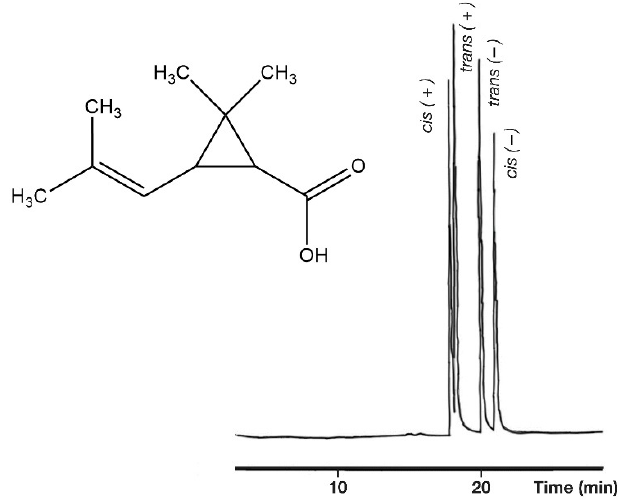
Figure 7. Chiral and cis ‐ trans separations of chrysanthemic acid isomers as free acids. The peaks of trans isomers elute between the peaks of cis isomers. Conditions: instrument, Shimadzu GC/MS ‐ QP5000 GC/MS; column, 25 m × 0.22 mm; stationary phase, Cydex ‐ B (0.25 μ m); carrier, He (50 cm/s); temperature, 135 °C.